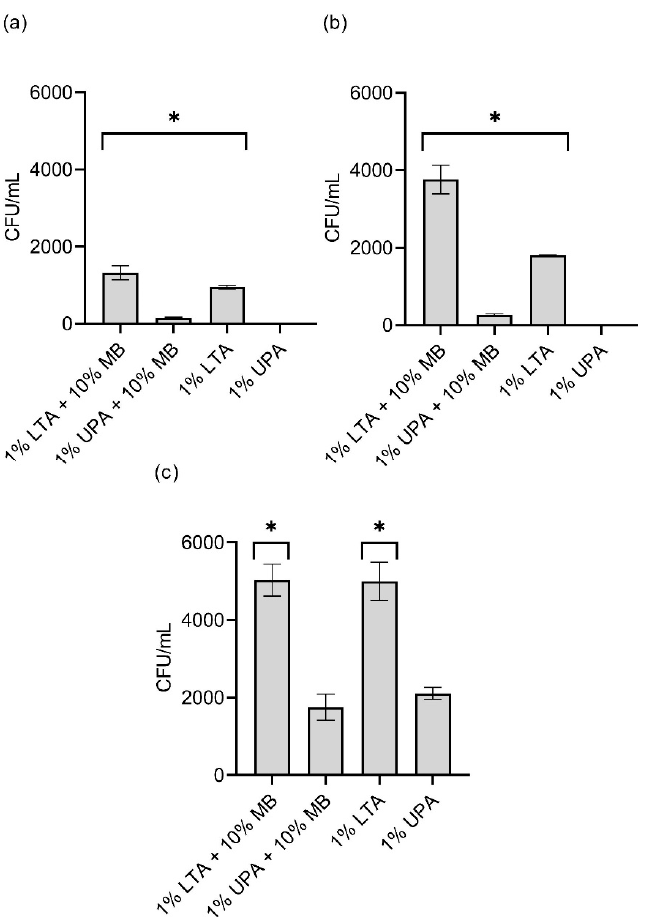
Figure 1. Effect of matrix on encapsulation. Viability after encapsulation of three representative marine sediment bacteria: ( a ) M. polaris , ( b ) P. aquimaris , and ( c ) B. licheniformis , using four matrices assessed via colony counts ( n = 3) measured by colony-forming units per volume (CFL/mL). Error bars reflect standard error, and * denotes significance of p < 0.05 between modified matrix and 1% UPA.